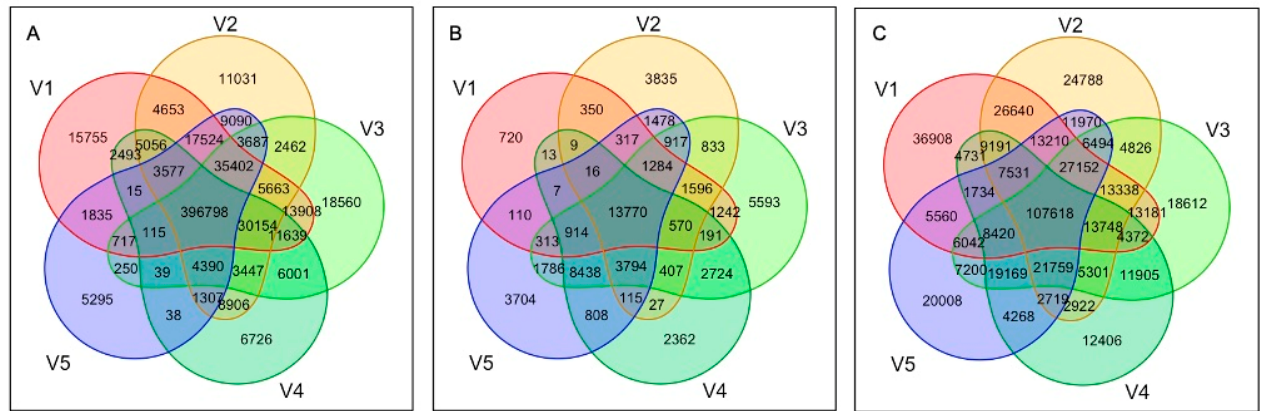
Figure 6. Venn diagram depicting the number of SNPs identified as true-positives from the best performing pipelines. Number of overlapping SNPs with reference set were shown for ( A ) variants merged for 48 samples, and ( B ) variants merged for 48 samples and filtered by missing genotypes ( C ) variants merged for 48 samples and filtered by missing genotypes after imputation. V1: STAR_BCFtools, V2: BWA-backtrack_BCFtools, V3: Bowtie2-local_BCFtools, V4: Bowtie2_BCFtools, and V5: BWA-backtrack_BCFtools.